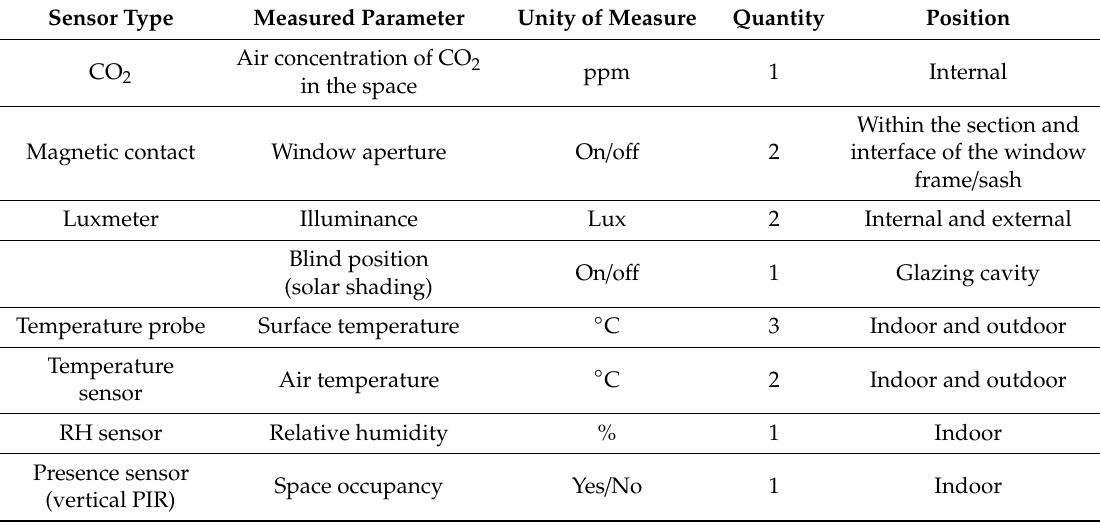
Figure 5. The details of the ELISIR window unit. All reported measurements are in mm. Table 1. List of the sensors integrated into the smart window